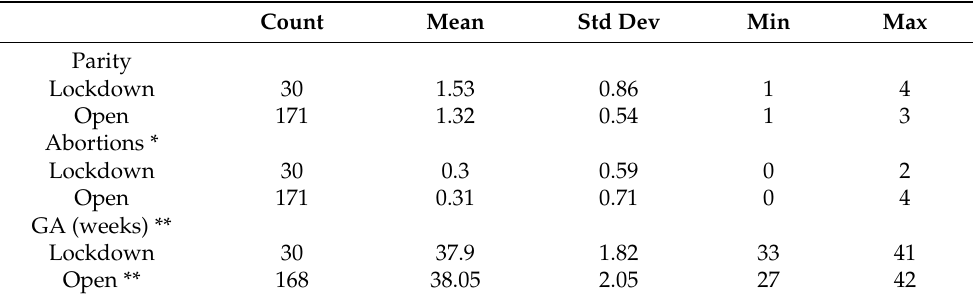
Table 2. Summary of obstetric